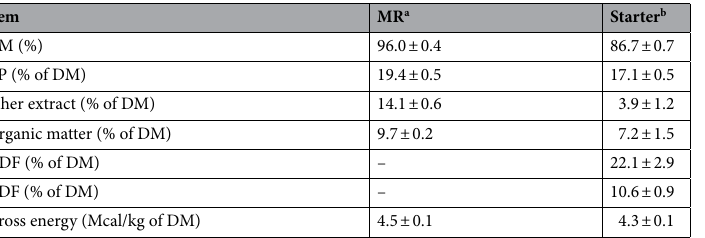
Table 1. Nutrient composition (% DM basis ± SD) of milk replacer (MR) and starter. a Powder integral milk, wheat isolated protein, acidifying additive, whey, coconut oil, palm oil, vitamin A, Vitamin D3, Vitamin E, Vitamin C (Kalvolak, Nutrifeed, Netherlands). b Basic composition: oats (rolled grains), calcitic limestone, sodium chloride, corn gluten meal, defatted corn germ, wheat bran, soybean meal, rice hulls, kaolin, molasses, flocculated corn, ground corn, corn grain, alfalfa hay, monensin, citrus pulp, dried sugarcane yeast, whole toasted soybean, sodium selenite, copper sulfate, manganese sulfate, cobalt sulfate, iron sulfate, zinc sulfate, calcium iodate, vitamin A, vitamin B1, vitamin B12, vitamin B2, vitamin B6, vitamin C, vitamin D3,